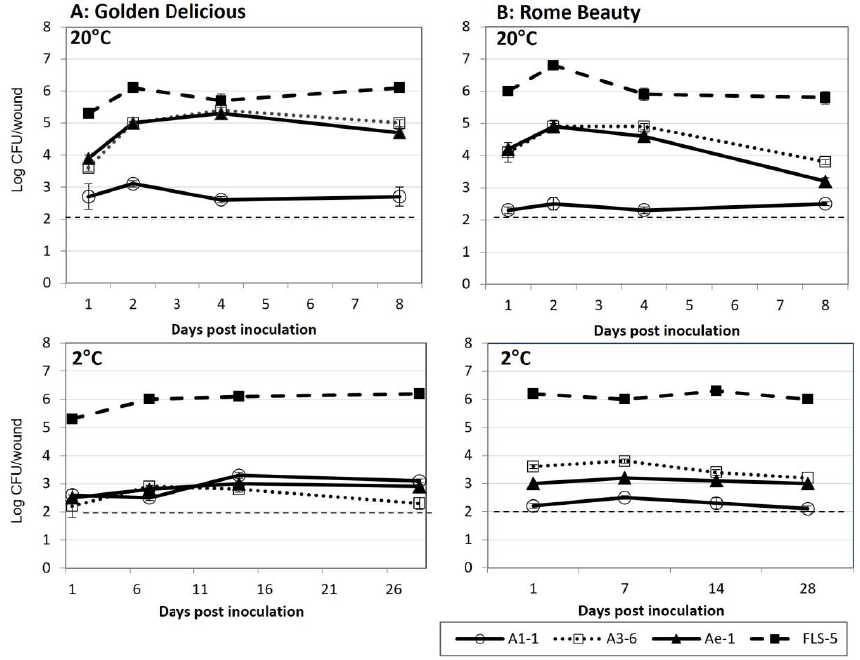
Figure 3. Colonization of fruit wounds by bacterial isolates A1-1, A3-6, Ae-1, and FLS-5 at 20 °C and 2 °C on ( A ) Golden Delicious and ( B ) Rome Beauty. Data are reported as log CFU/wound. Wounds were inoculated with 2.0 × 10 5 CFU/wound. Error bars represent the standard error of the mean. The dashed line indicates the minimum detection level of the experiment.